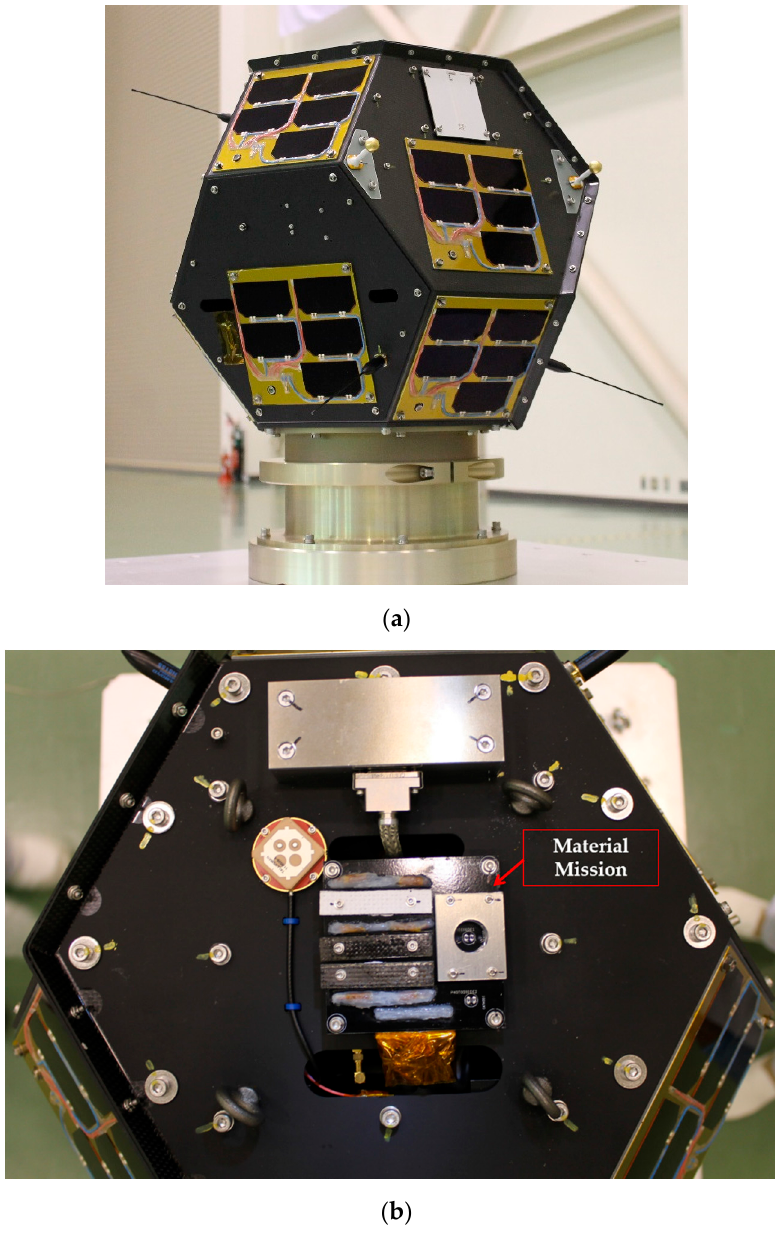
Figure 1. Ten-Koh satellite configuration and location of material mission (MM). ( a ) Ten-Koh flight model (FM); ( b ) location of MM on top of Ten-Koh external structure.